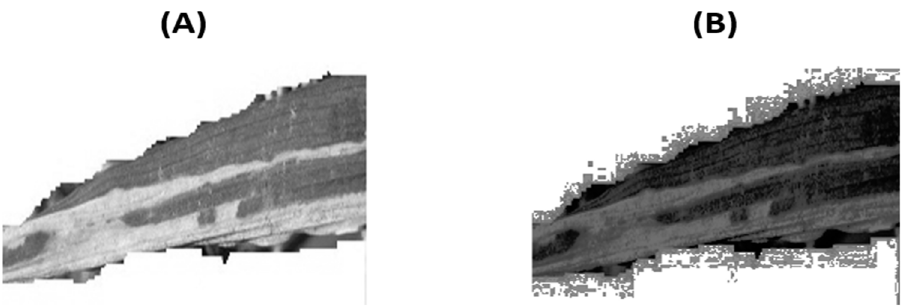
Figure 5. Global Equalization: ( A ) original greyscale; ( B ) post-equalization.